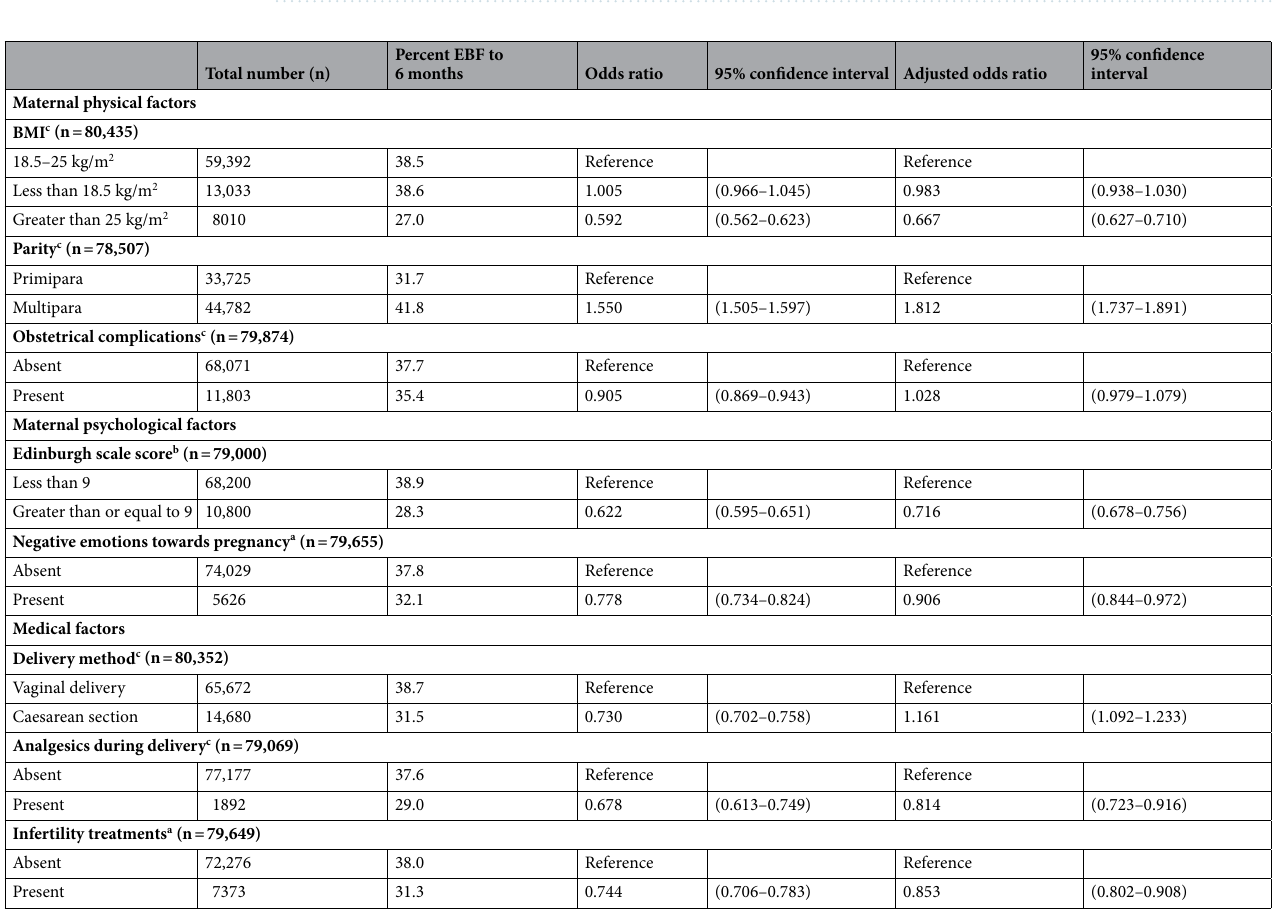
Table 4. Maternal physical, psychological and medical factors influencing EBF rates until 6 months postpartum in Japan. Data acquisition. a During early pregnancy/ b 1 month postpartum/ c attending physician diagnosed just after